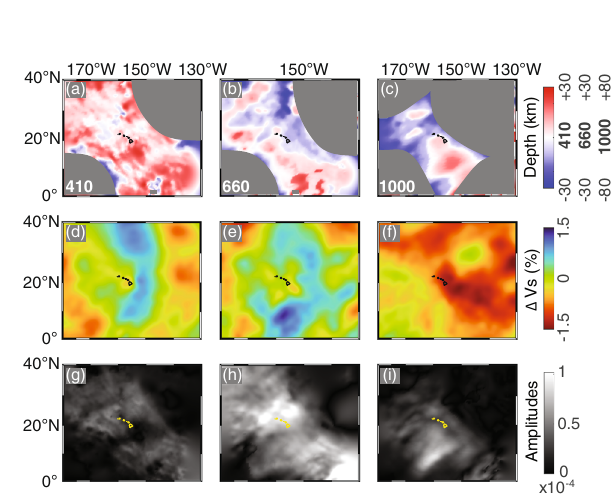
Fig. 5 | Comparison between discontinuity topography, shear wavespeed anomaliesand picked re fl ector amplitudes. Top row: our imaged topography of the 410km, the 660km, and the 1000kmdiscontinuities.Middlerow: depthslices through the GLAD-M25 tomographic model of shear wave speed perturbations at 410,660,and1000kmdepth.Bottomrow:re fl ectoramplitudesextractedfromour reverse time migration